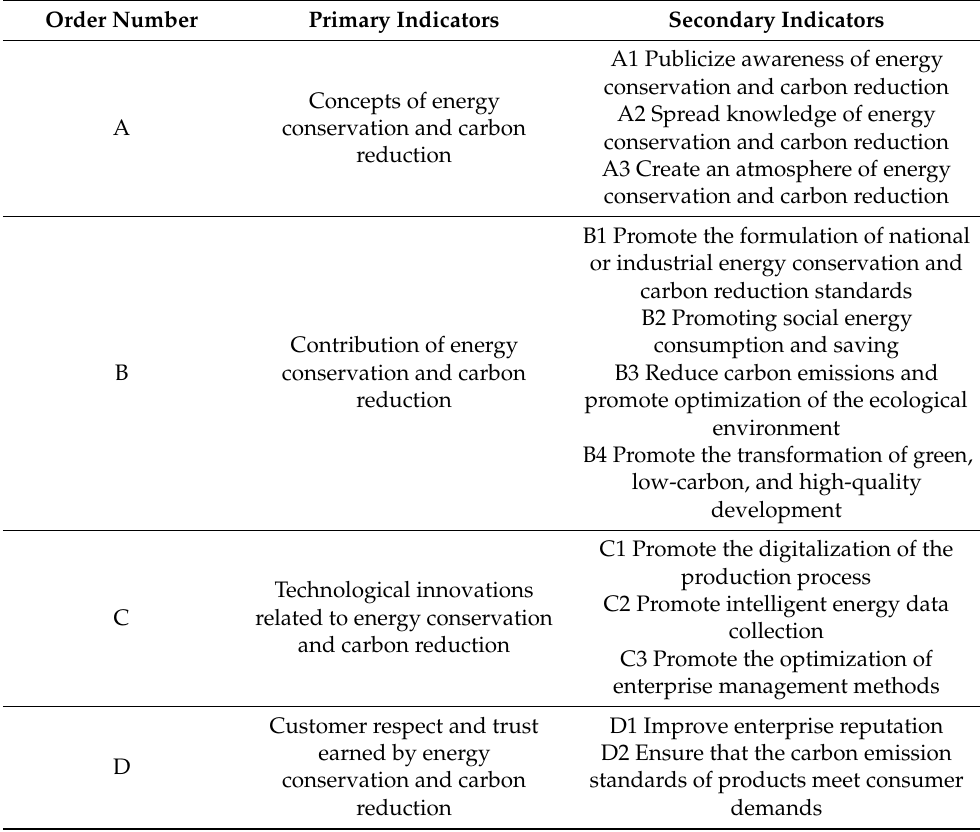
Table 2. Evaluation index system of the social effects of enterprise carbon